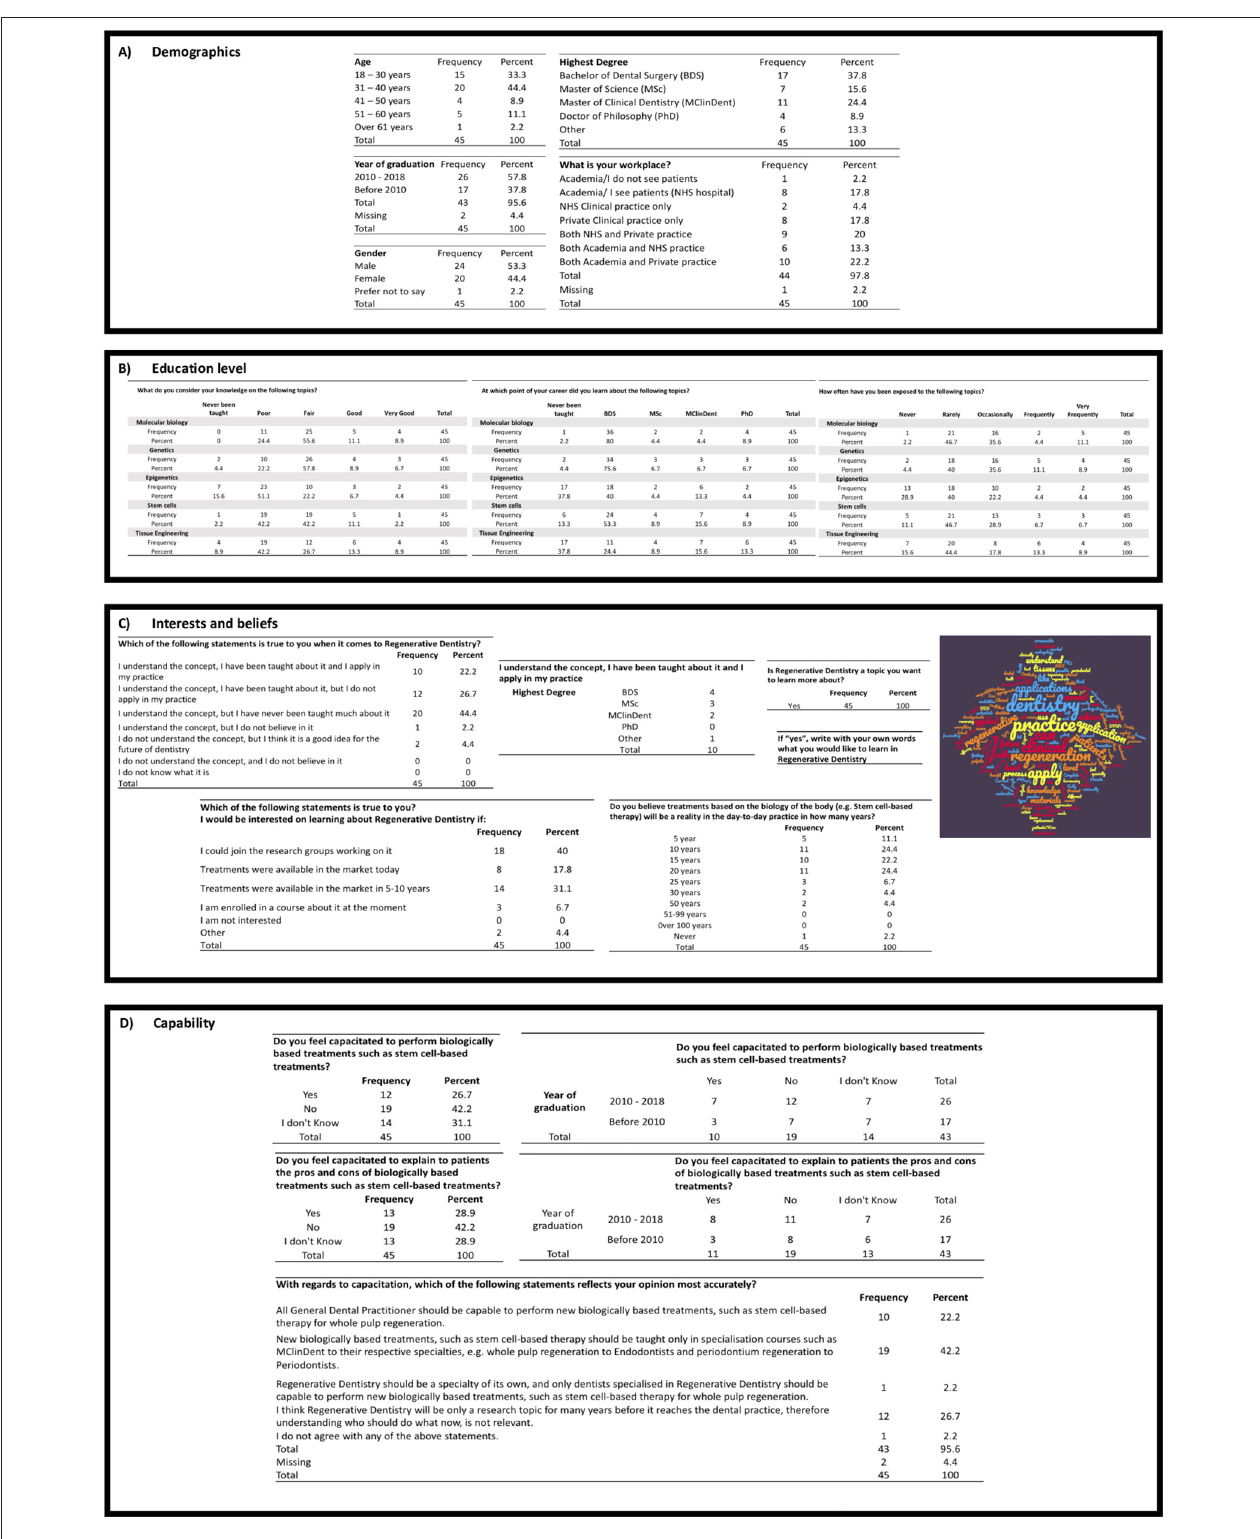
FIGURE 1 | Questions and answers about demographics, education level, interests and beliefs, and capability.